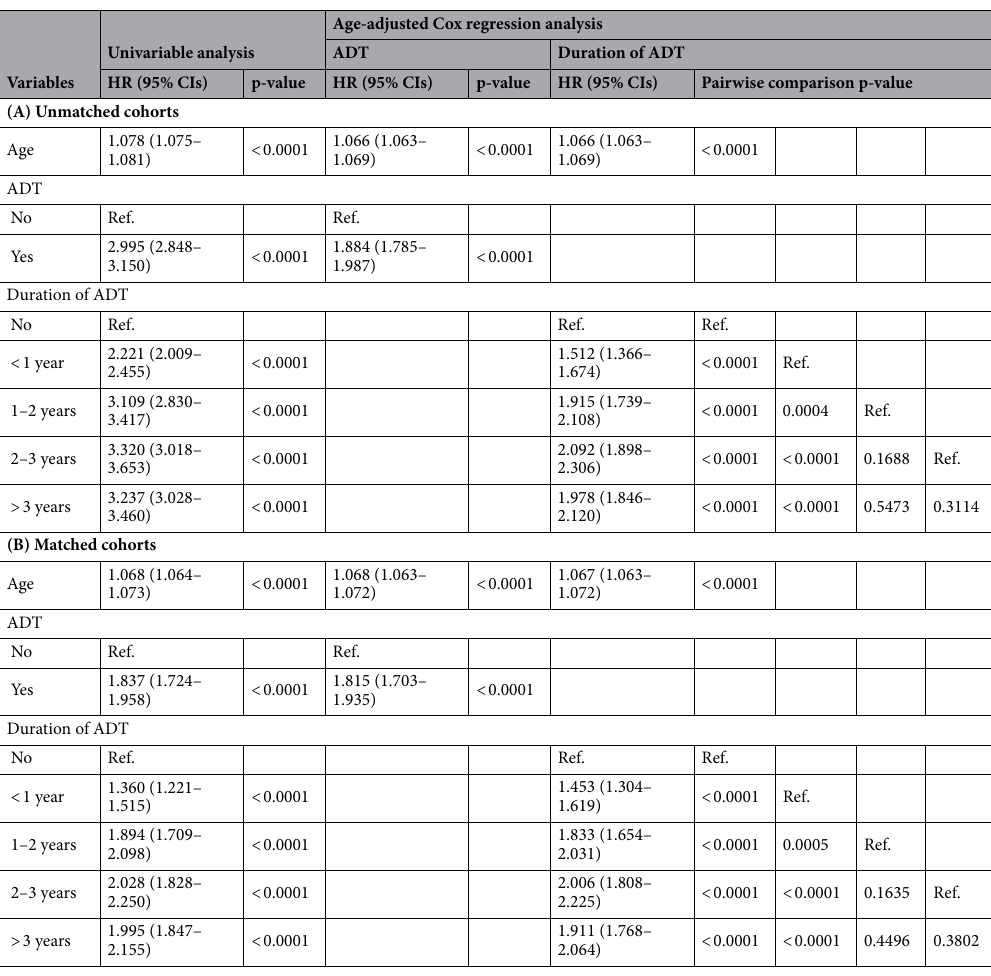
Table 3. Age-adjusted Cox regression analysis for predicting fractures in the unmatched (A) and matched (B) cohorts. ADT androgen deprivation therapy, CI confidence interval, HR hazard